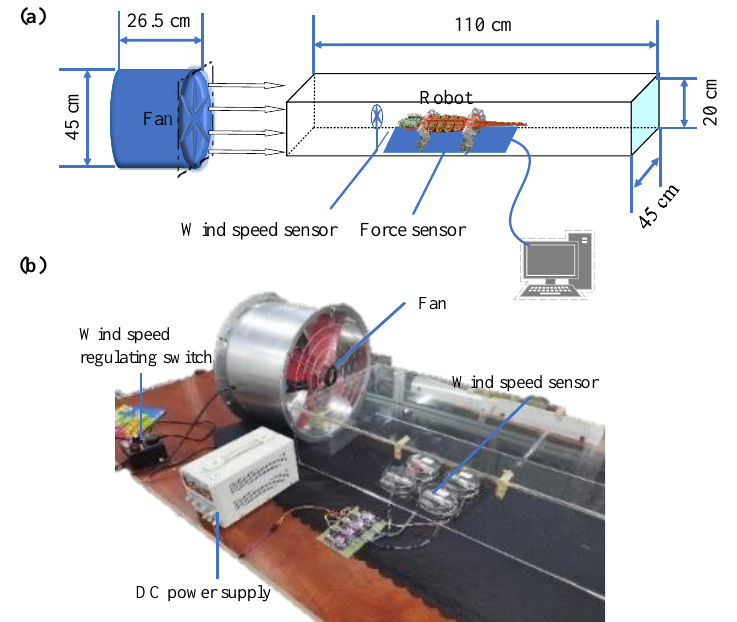
Figure 18. Small wind tunnel test platform: ( a ) schematic diagram and ( b ) experimental